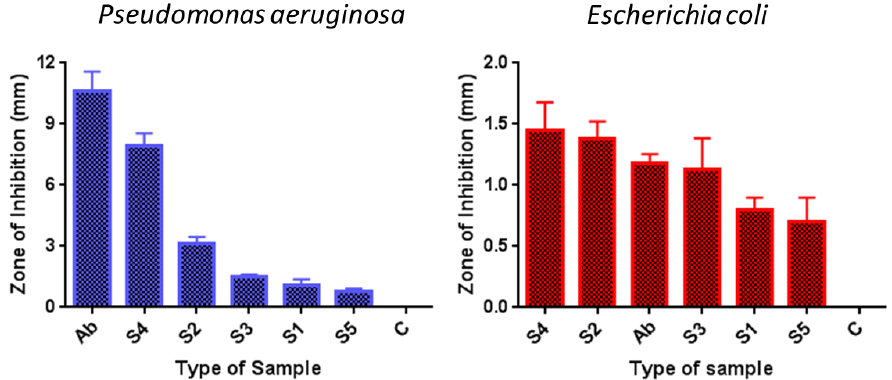
Figure 8. Antibacterial activity (high to low) of silver nanoparticles (AgNPs) against Pseudomonas aeruginosa and Escherichia coli.